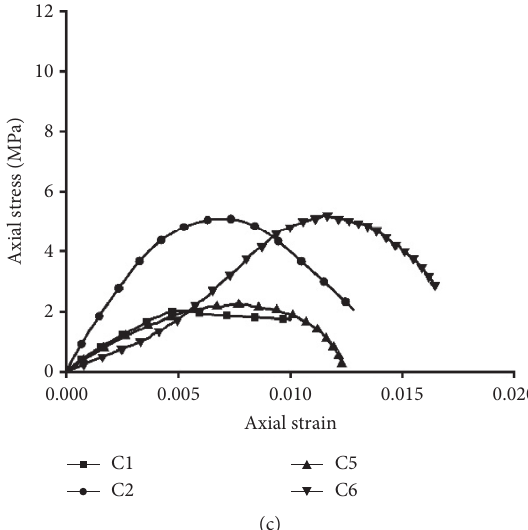
Figure 6: Stress-strain curve of the dynamic tensile test. (a) Axial static load of 0MPa. (b) Axial static load of 0.289MPa. (c) Axial static load of 0.578MPa.